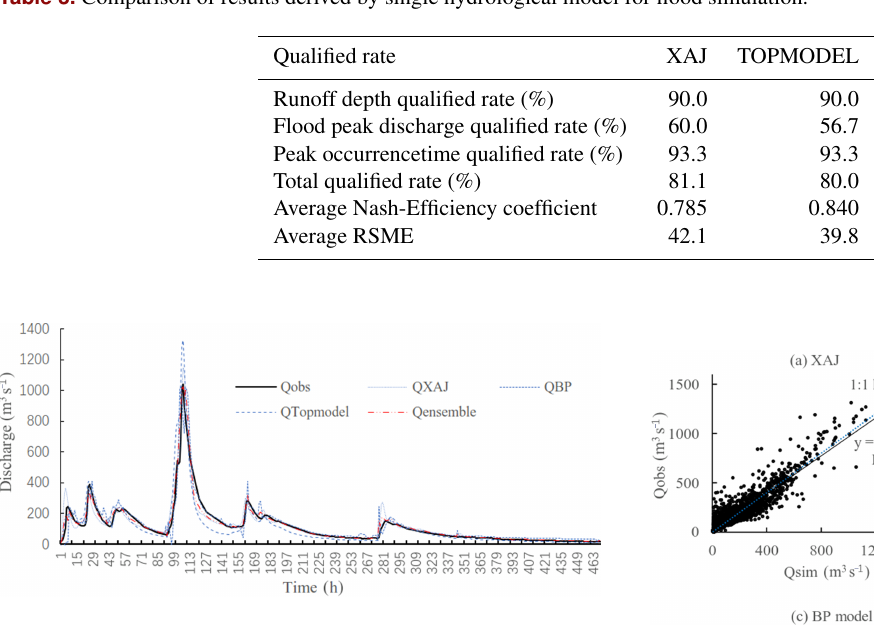
Figure 7. Observed and simulated hydrographs of 820716 flood in the Yandu River Catchment.